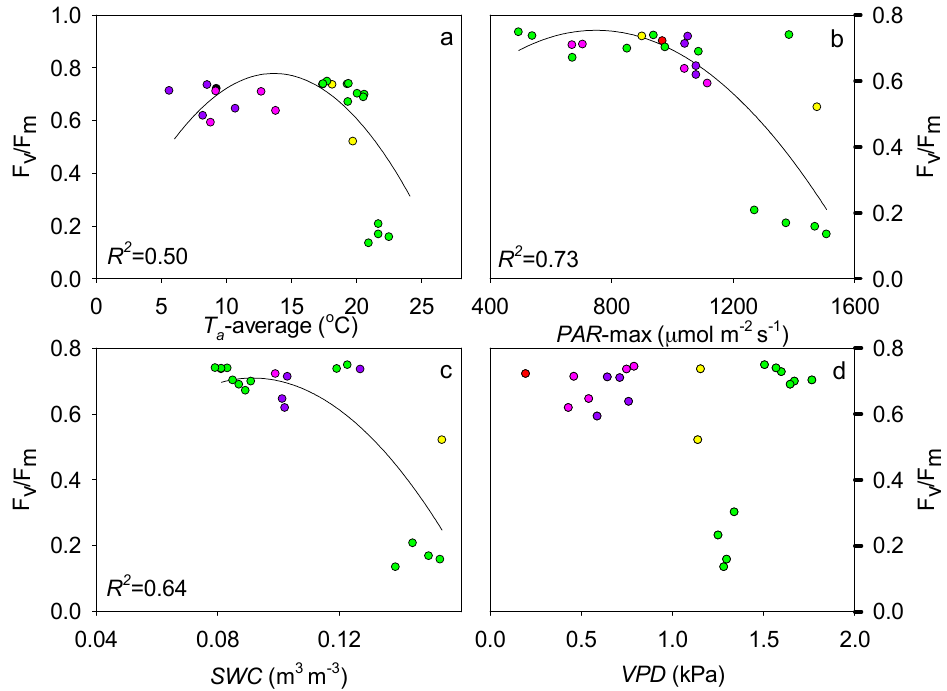
Figure 9. Maximal quantum yield of PSII photochemistry in Salix psammophila as a function of daily mean air temperature ( T a , R 2 = 0.60, ( a )), daily maximal photosynthetically active radiation ( PAR , R 2 = 0.73, ( b )), soil water content ( SWC , R 2 = 0.65, ( c )), and vapor pressure deficit ( VPD , ( d )) during the 2012 growing season. Data points are those with F v /F m < 0.75, where photoinhibition occurred.